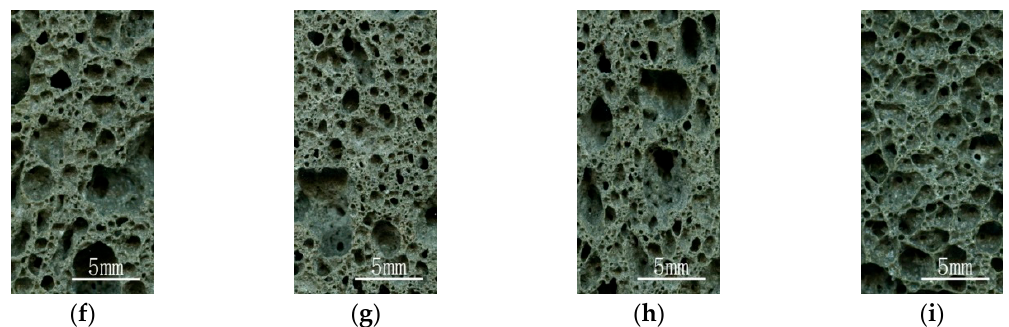
Figure 1. Aperture structure images of the foam glass samples, which are correspondingly numbered